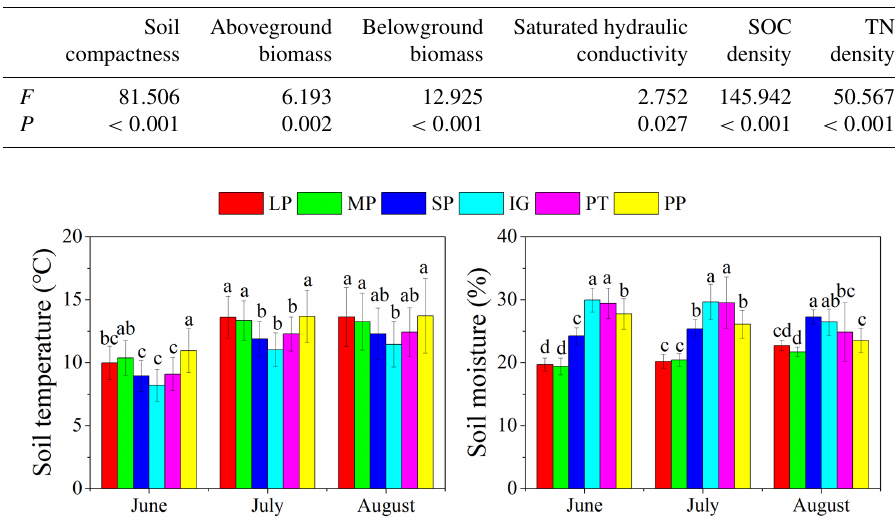
Figure 4. Monthly average soil temperature and soil moisture at 10cm depth in different surface types: (1) large bald patch (LP), (2) medium bald patch (MP), (3) small bald patch (SP), (4) intact grassland patch (IG), (5) above pika tunnel (PT) and (6) old pika pile (PP).